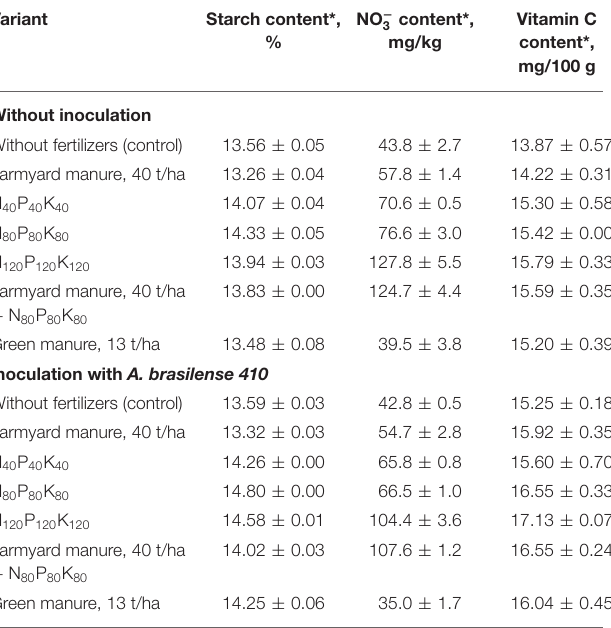
TABLE 4 | The effect of fertilizers and inoculation on the product quality indicators (2018).